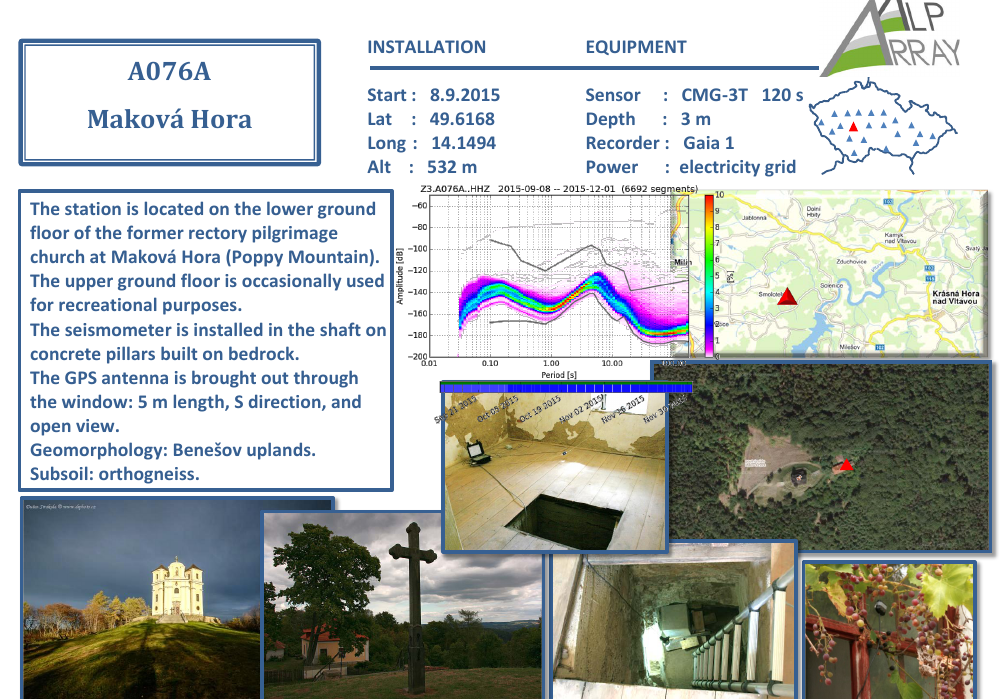
Figure 4. Example of installation of one of the broadband MOBNET stations in the AlpArray Seismic Network (AASN). In addition to the photo-documentation of the installation of the A076A station (Maková Hora), we show its location (upper right), station coordinates, and start time of recordings (top panel), and we describe the installation including accessories (GPS antenna) and the bedrock (left panel in the middle). The central panel shows the probabilistic power spectral density of ambient noise during the first 4 months of the station registration.